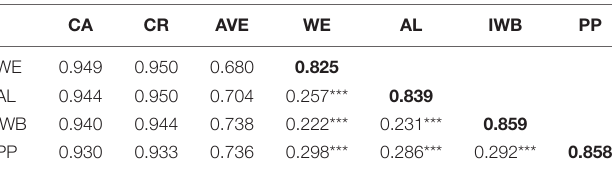
TABLE 2 | Reliability and validity